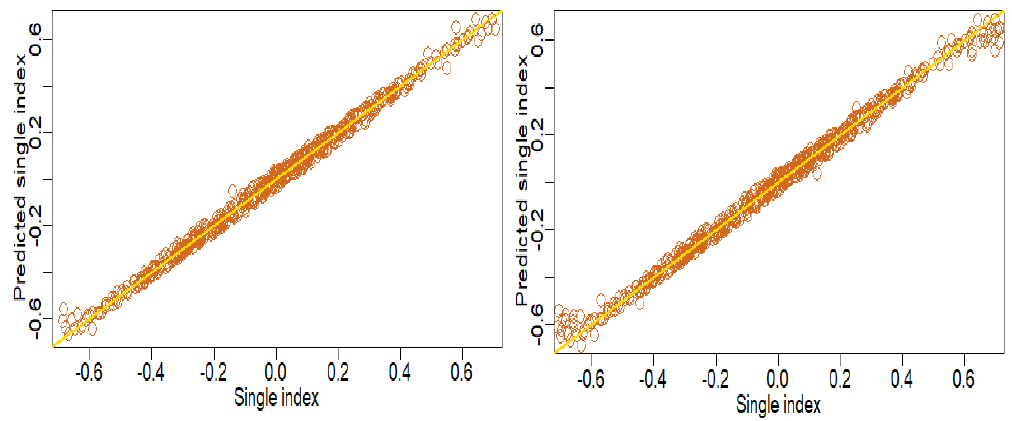
Figure 3. On the left plot: single-index versus predicted single-index, Gaussian case. On the right plot: single-index versus predicted single-index, logistic